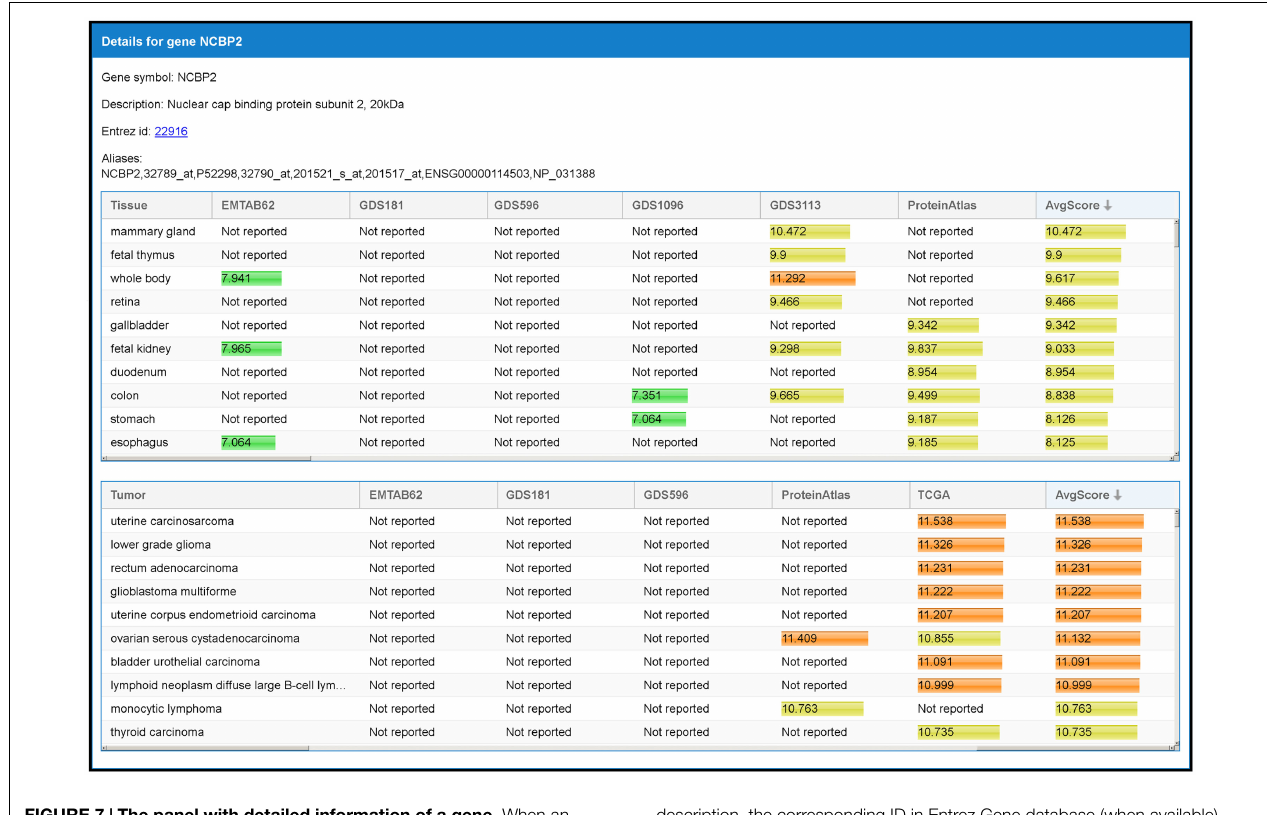
FIGURE 7 | The panel with detailed information of a gene . When an interaction is selected from the result table ( Figure 6 ), two panels with additional data, one for each interacting gene, are shown. This example refers to the detailed panel for gene NCBP2, which appears when the row table of Figure 6 is selected. In the detailed panel, the gene symbol, the